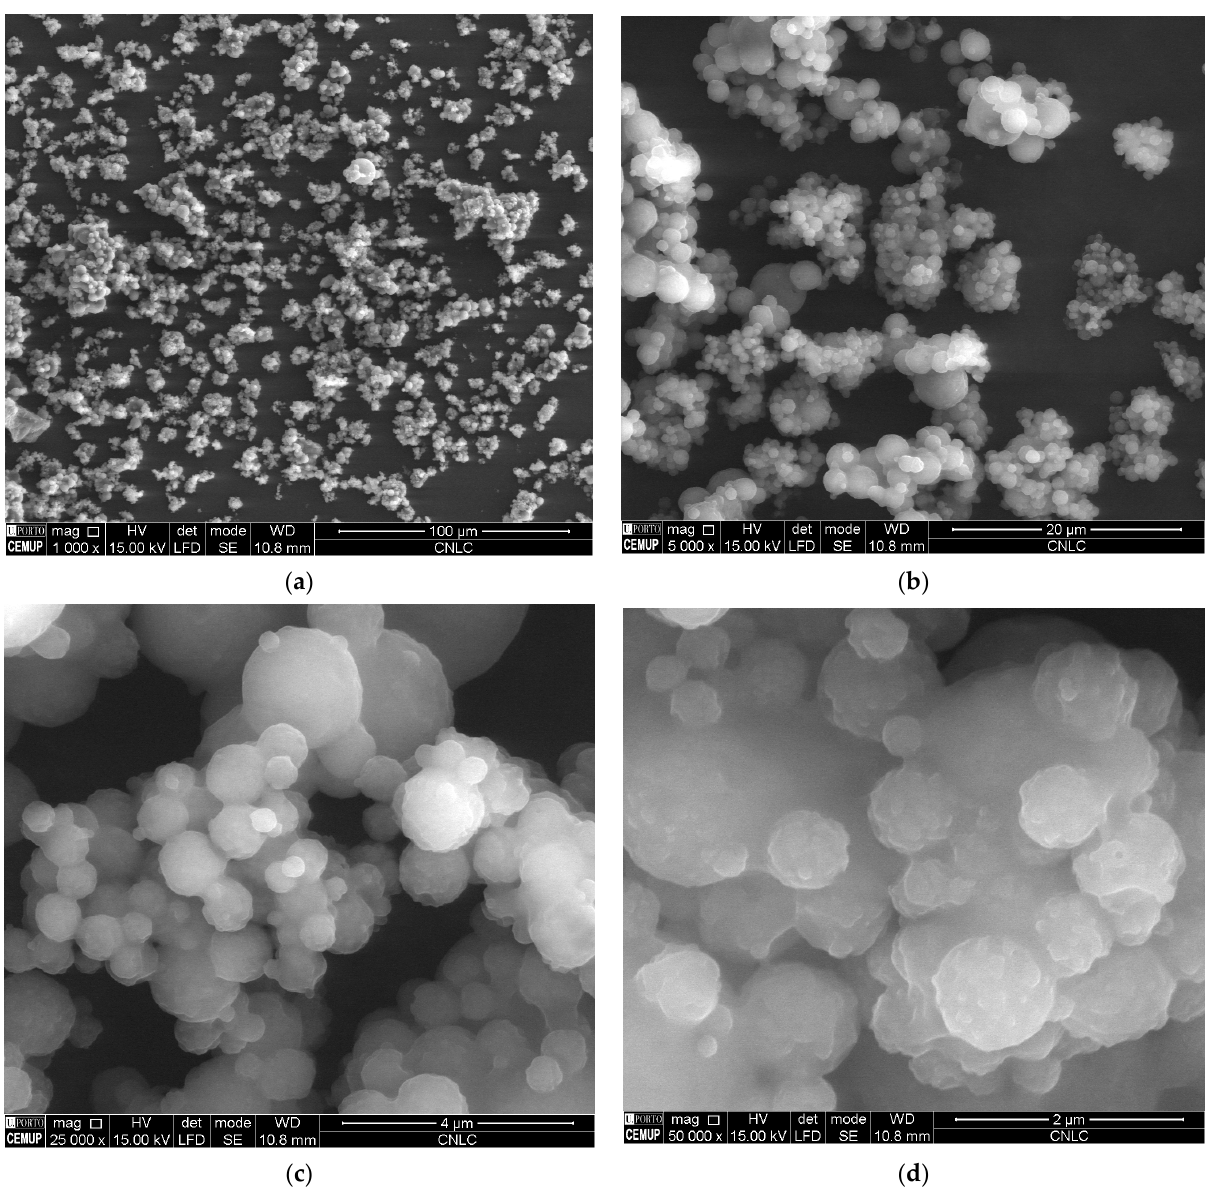
Figure 8. Scanning electron microscopy analysis of CBD-loaded cNLC at different resolutions, ( a ) 1000×, ( b ) 5000×, ( c ) 25,000×, and ( d ) 50,000×.